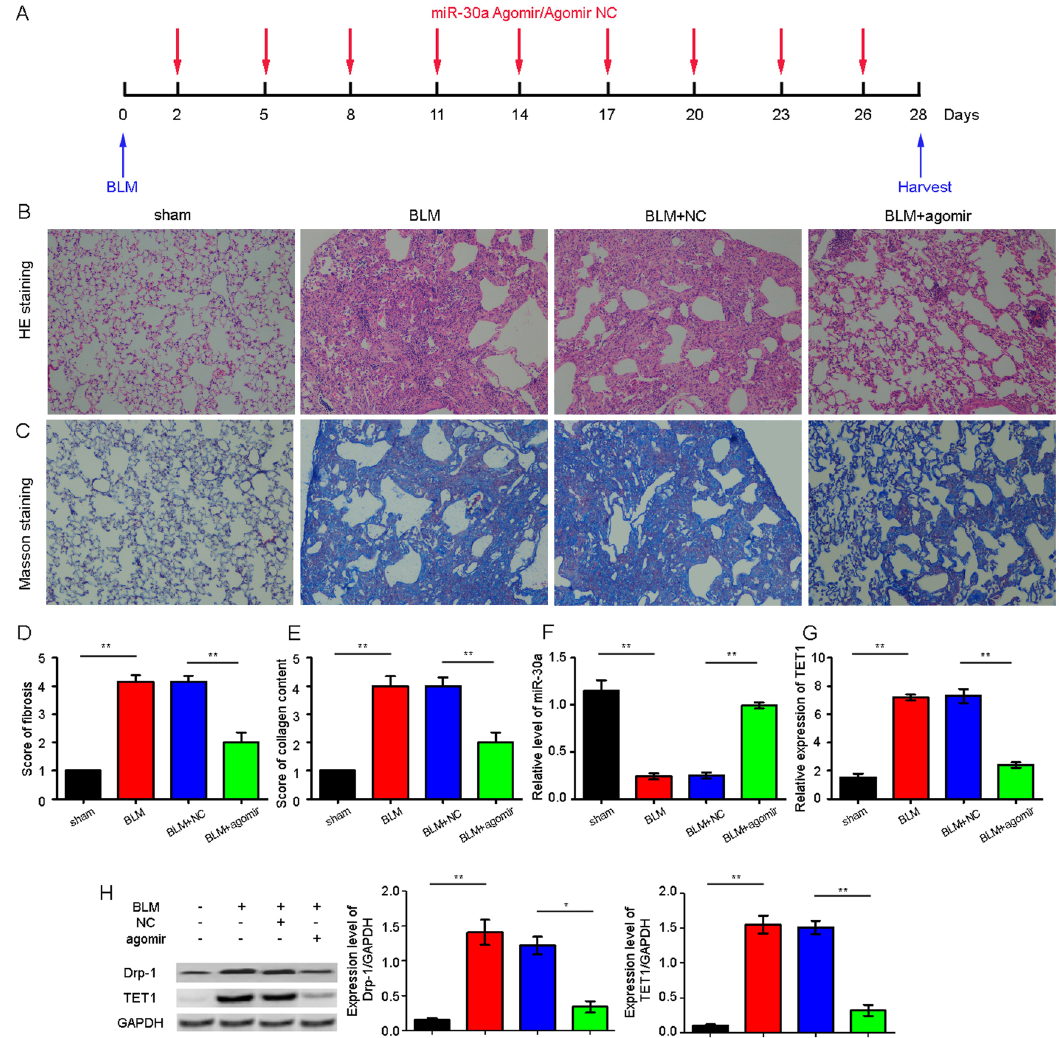
Figure 4. miR-30a as a potential therapeutic target for IPF. ( A ) Schematic of the miR-30a agomir action; ( B ) miR-30a agomir could improve the alveolar structure in vivo through hematoxylin and eosin (H&E)staining, × 400 magnification; ( C ) miR-30a agomir could inhibit the collagen fibers through Masson’s staining. The color blue represents collagen fibers, × 400 magnification; ( D ) Score of lung fibrosis on H&E staining; ( E ) Score of collagen content on Masson’s staining; ( F ) Mice sprayed with agomir had increased miR-30a expression compared with those in the bleomycin (BLM)group based on qRT-PCR; ( G ) Mice sprayed with agomir had decreased TET1 expression compared with those in the BLM group based on qRT-PCR; ( H ) Mice sprayed with agomir had decreased Drp-1 and TET1 expression compared with those in the BLM group based on the Western blot. +/ − Indicates with or without reagent respectively. Each bar represents the mean ± SD, n = 6, * p < 0.05, ** p <